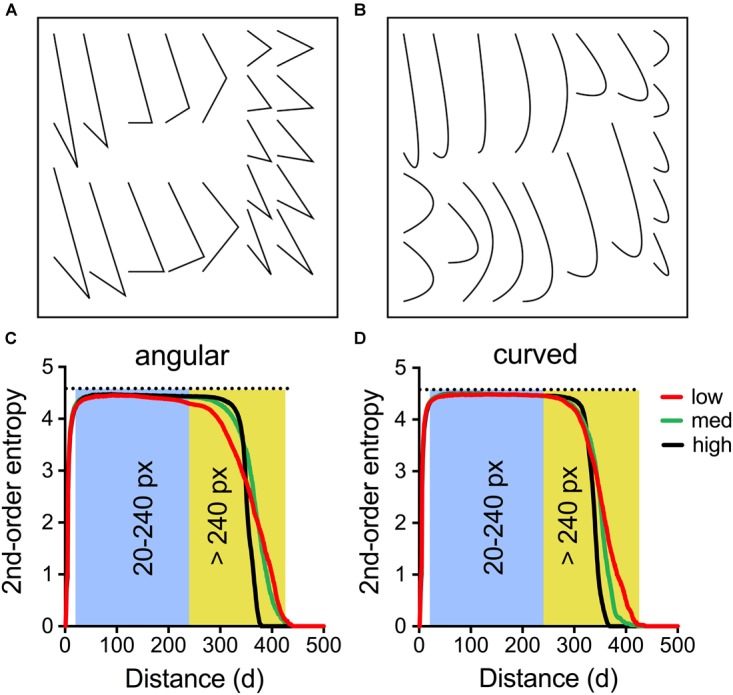
Characteristics of the line stimuli used in Experiment 6. The stimuli were composed of a set of either angular line elements (A) or curved ones (B). Each set was used twice in each stimulus, resulting in 40 line elements per stimulus (see Figure 7). In (C,D), the mean 2nd-order entropy for the angular stimuli (C) and the curved stimuli (D) was plotted as a function of pixel distance for the 10 stimuli with lowest entropy values above 240 pixels distance (low, red lines; angular Median: 3.25, Range: 3.19–3.44; curved Median: 3.44, Range: 3.33–3.52), with the values closest to the median entropy (med, green lines; angular Median: 3.77, Range: 3.68–3.83; curved Median: 3.80, Range: 3.70–3.90) and with the highest entropy values (high, black lines; angular Median: 4.11, Range: 4.06–4.20; curved Median: 4.14, Range: 4.09–4.21), respectively. The shaded areas indicate the distance between 20–240 pixels and >240 pixels, respectively.